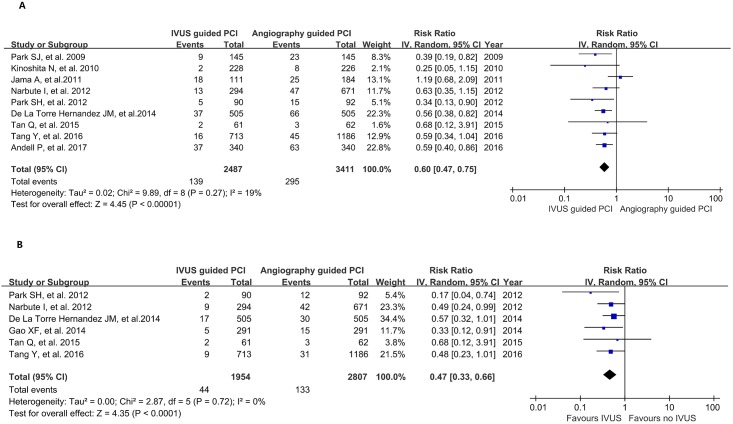
Forest plot of primary outcomes; (A) all-cause death; (B) cardiac death.